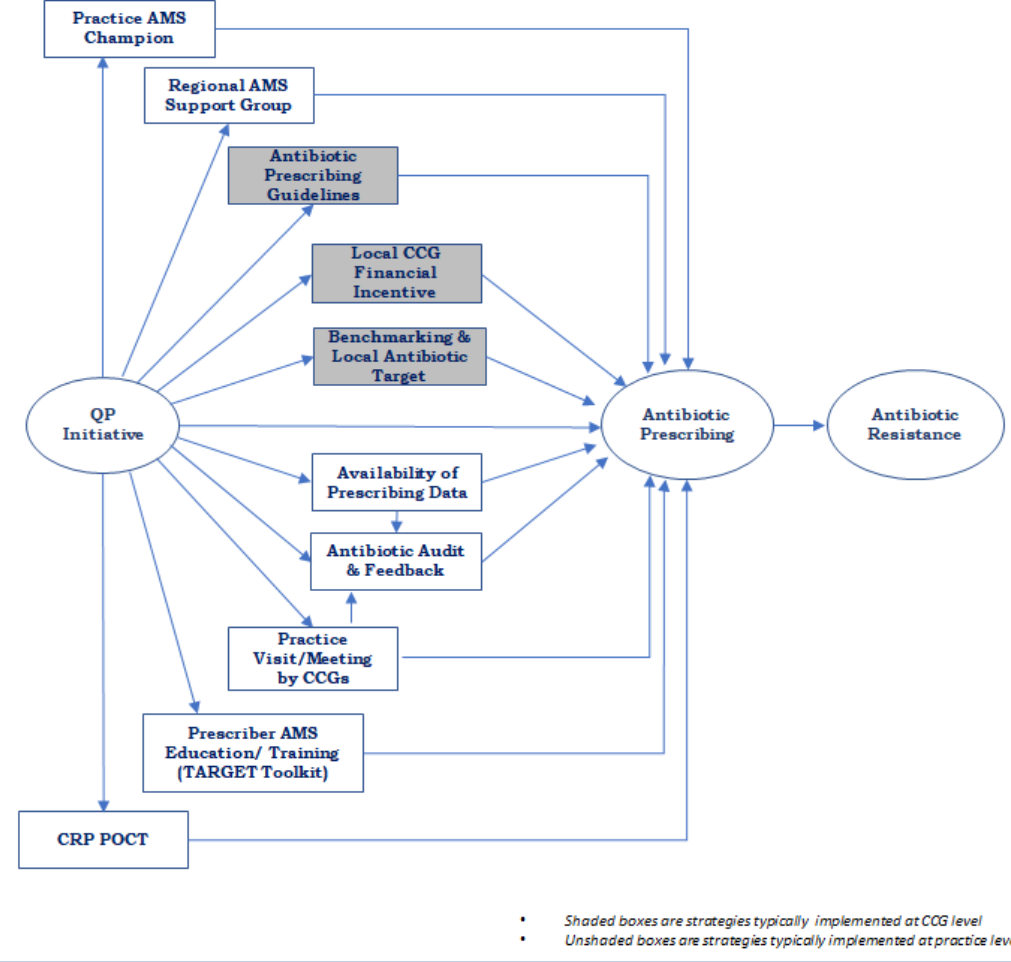
Figure 1. Conceptual model developed by participants showing pathways from Quality Premium (QP) to antibiotic prescribing and resistance.